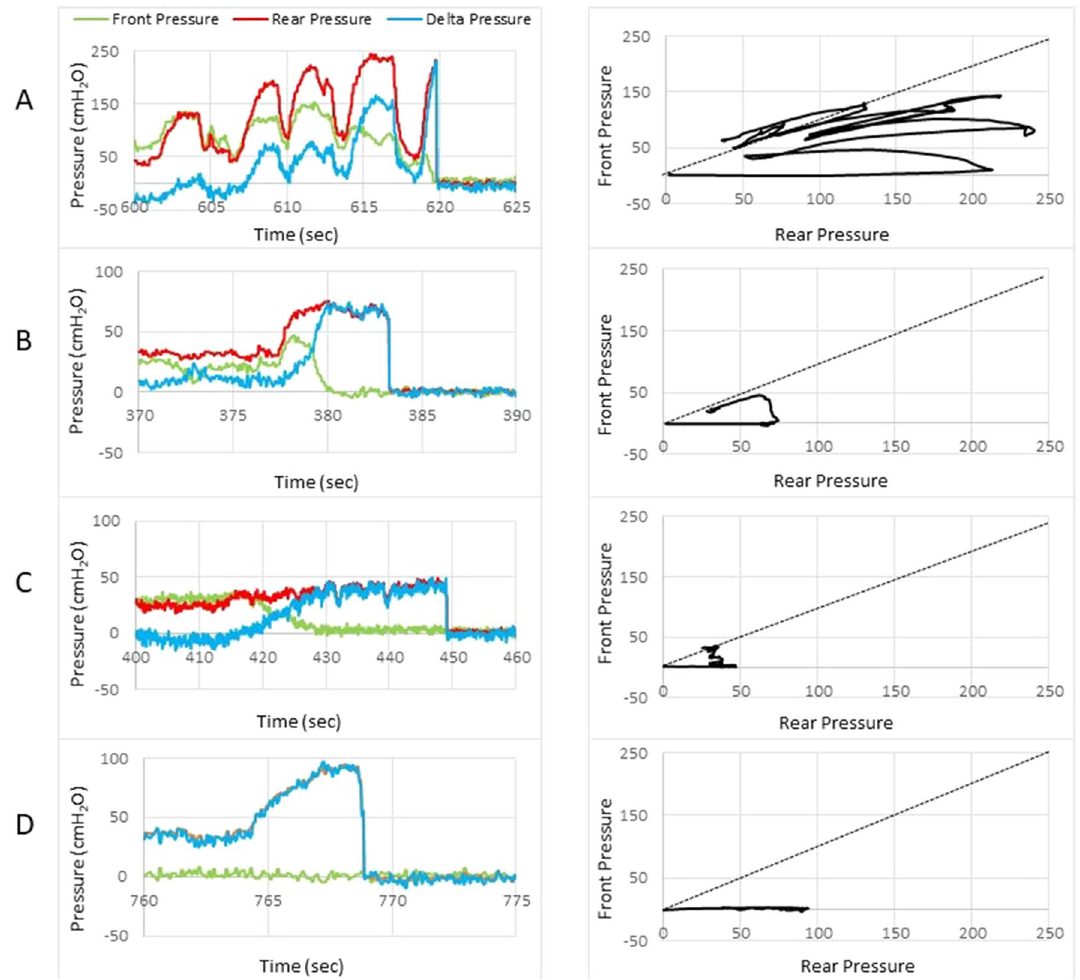
Figure 4. Representative examples of defecations from three FI patients and a normal subject. The left diagrams illustrate the front and rear pressures and the delta pressure as function of time. The right diagrams show the front pressure as function of the rear pressure. The stippled line is the line of unity (front pressure equals rear pressure). The patients defecated Fecobionics with one contraction whereas the normal subject used five contractions. A large variety was found in FI patients where some patients appeared like normal subjects. Others had very low anal